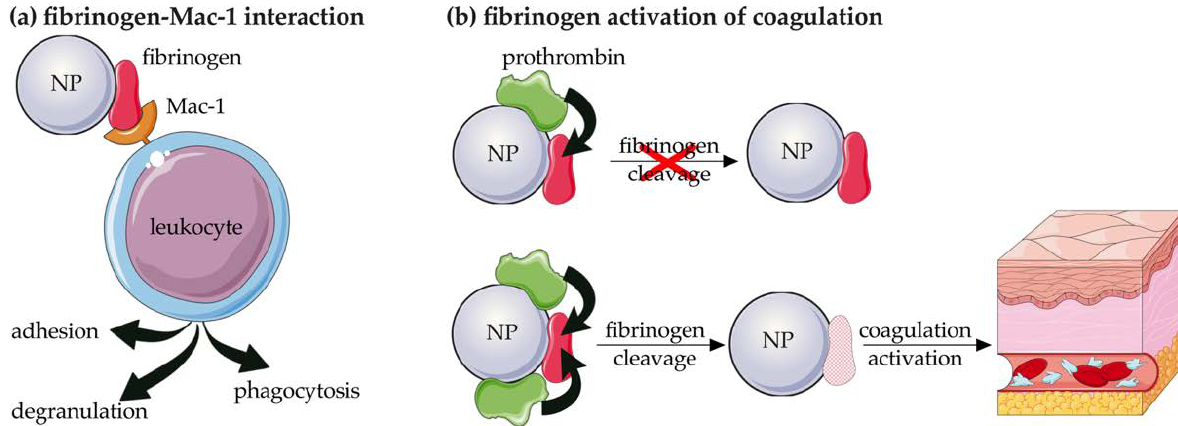
Figure 6. Schematic representation of the mechanisms mediated by the deposition of fibrinogen on NPs. ( a ) interaction with Mac-1 receptor expressed by leukocyte and ( b ) direct lysis of fibrinogen. NP: nanoparticle. The figure was partly generated using Servier Medical Art by Servier, licensed under the Creative Commons Attribution 3.0 Unported Licence.